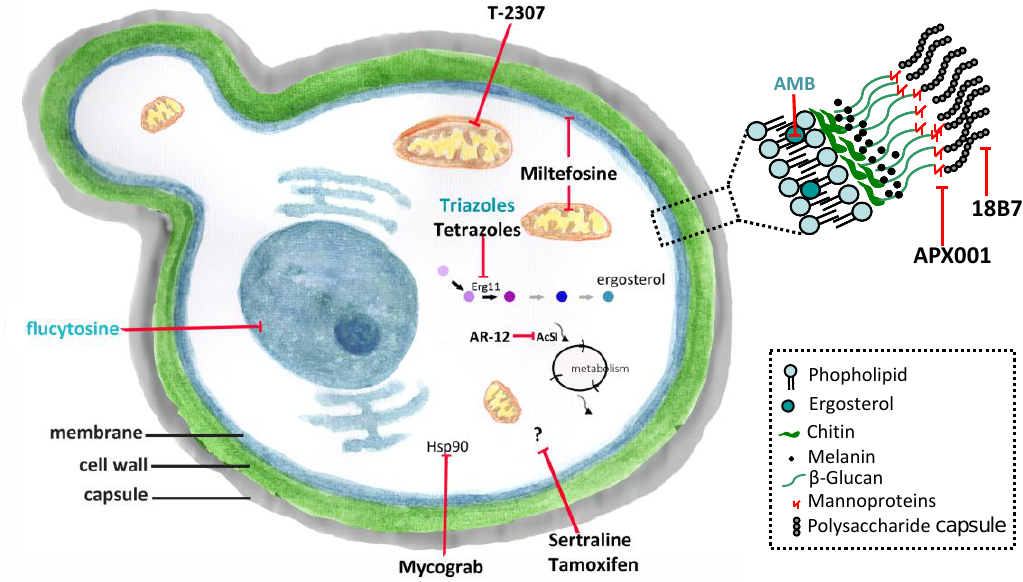
Figure 1. Conventional antifungals and new molecules for cryptococcosis treatment. Amphotericin B (AMB) and azoles inhibit ergosterol and its biosynthesis, respectively, and flucytosine inhibits the nucleic acids synthesis. New molecules acting on non-conventional targets or different structures of fungal cells may have antifungal effects. Erg11 (or Cyp51)—cytochrome P450-dependent lanosterol C14-alpha-demethylase; AcS—Acetyl CoA synthetase; Hsp90—Heat shock protein 90.